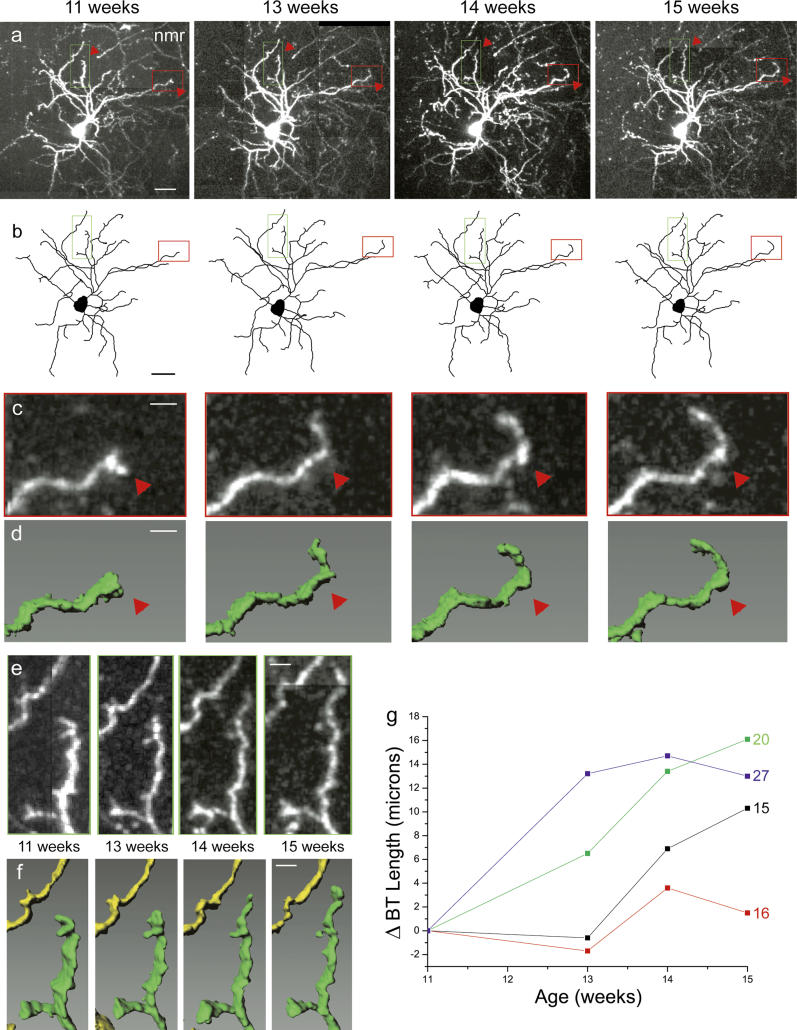
Dendritic Growth in Multiple Branches of a Non-Pyramidal Neuron(A) MZPs near the cell body of the (∼118-μm deep) non-pyramidal cell “nmr” acquired over 4 wk. Two examples of dendritic branch growth are indicated by red arrowheads.(B) Two-dimensional projections of three-dimensional skeletal reconstructions of the non-pyramidal neuron “nmr.”(C) High-magnification view of one growing branch tip (#20) (red box in [A and B]). Red arrowhead marks the approximate distal end of the branch tip at 11 wk.(D) Three-dimensional isosurface reconstructions of branch tips in (C).(E) High-magnification view of branch tip #15 (green box in [A and B]).(F) Three-dimensional isosurface reconstructions of branch tips in (E).(G) Plot of change in BTL of dynamic branch tips as a function of age. Number to the right denotes branch tip number.Scale bars: (A and B), 25 μm; (B–F), 5 μm.